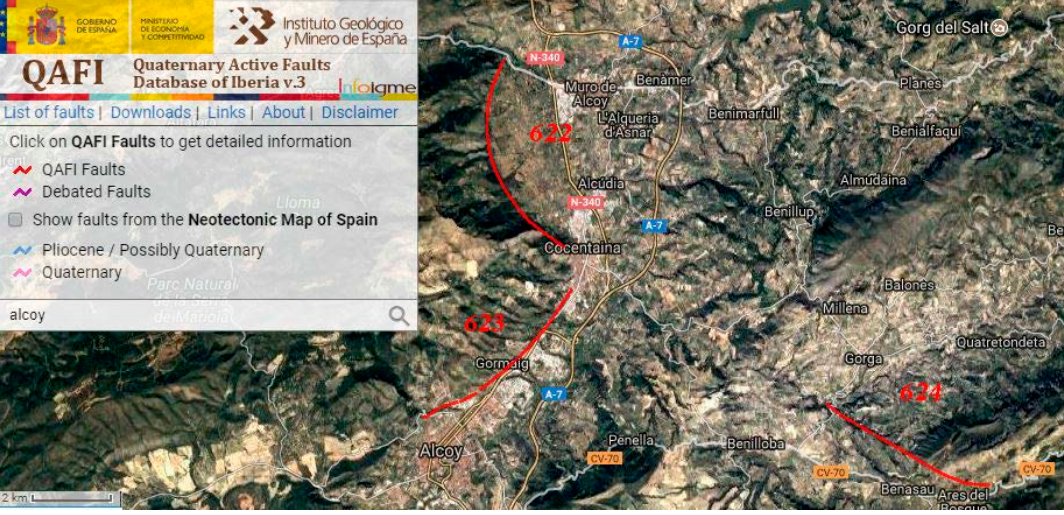
Figure 10. QAFI Map showing the location of seismogenic sources close to the Alcoy basin (http://info.igme.es/qafi/).